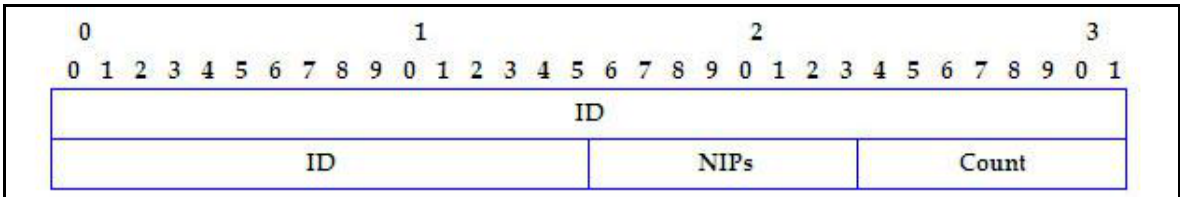
Figure 3. SERVER_DISCOVERY message